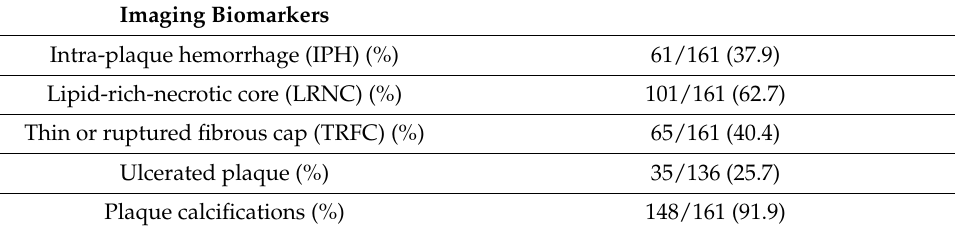
Table 2. Imaging biomarkers—number/total number of patients with percentage of total.